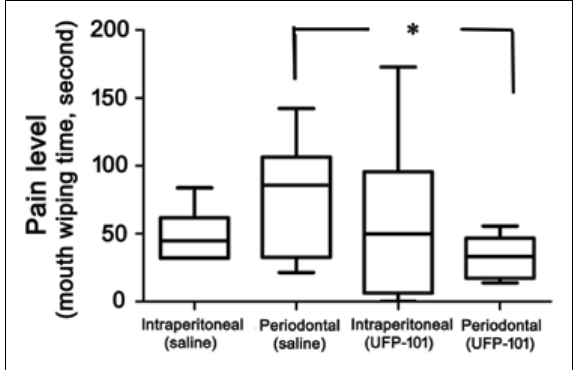
Figure 1. Orofacial pain levels (mouth wiping time, seconds) in the force group and the control group following experimental tooth movement. The plus and minus error bars stand for maximal and minimal values, respectively. The box stands for interquartile range and the horizontal line through the box stands for the median value.